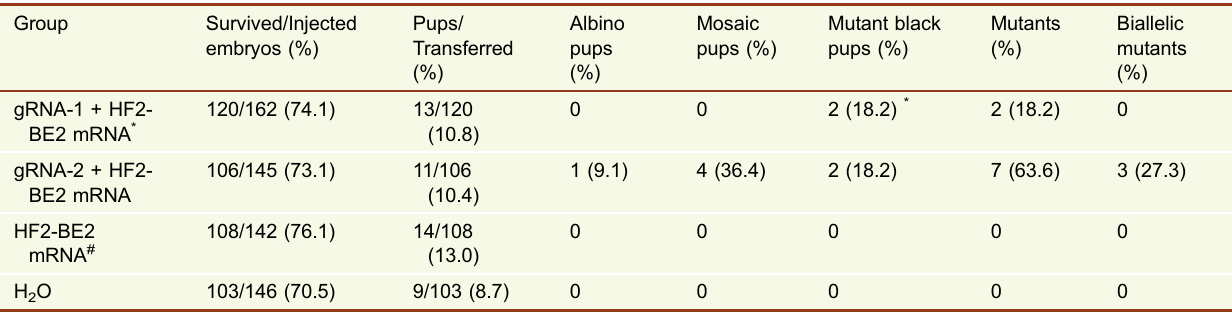
Table 1. Summary of base editing by HF2-BE2 in founder mice